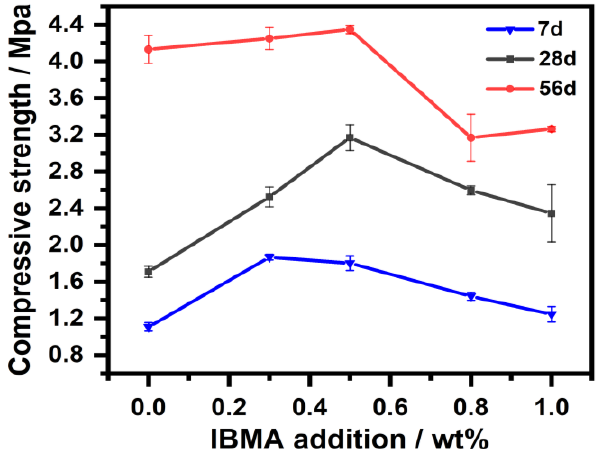
Figure 16. Compressive strength of NHL pastes with varying IBMA content after being cured for different time periods.